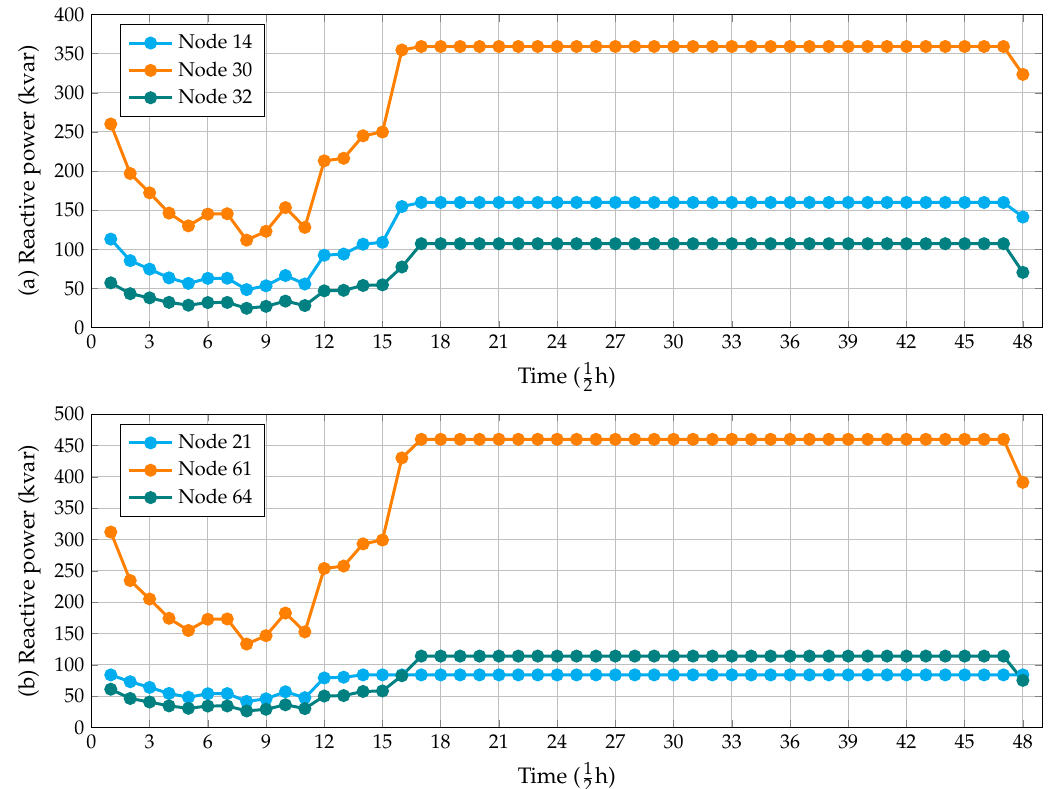
Figure 4. Dynamic reactive power behavior in a typical operation day for the D-STATCOMs in electric distribution networks: ( a ) IEEE 33-bus, and ( b ) IEEE